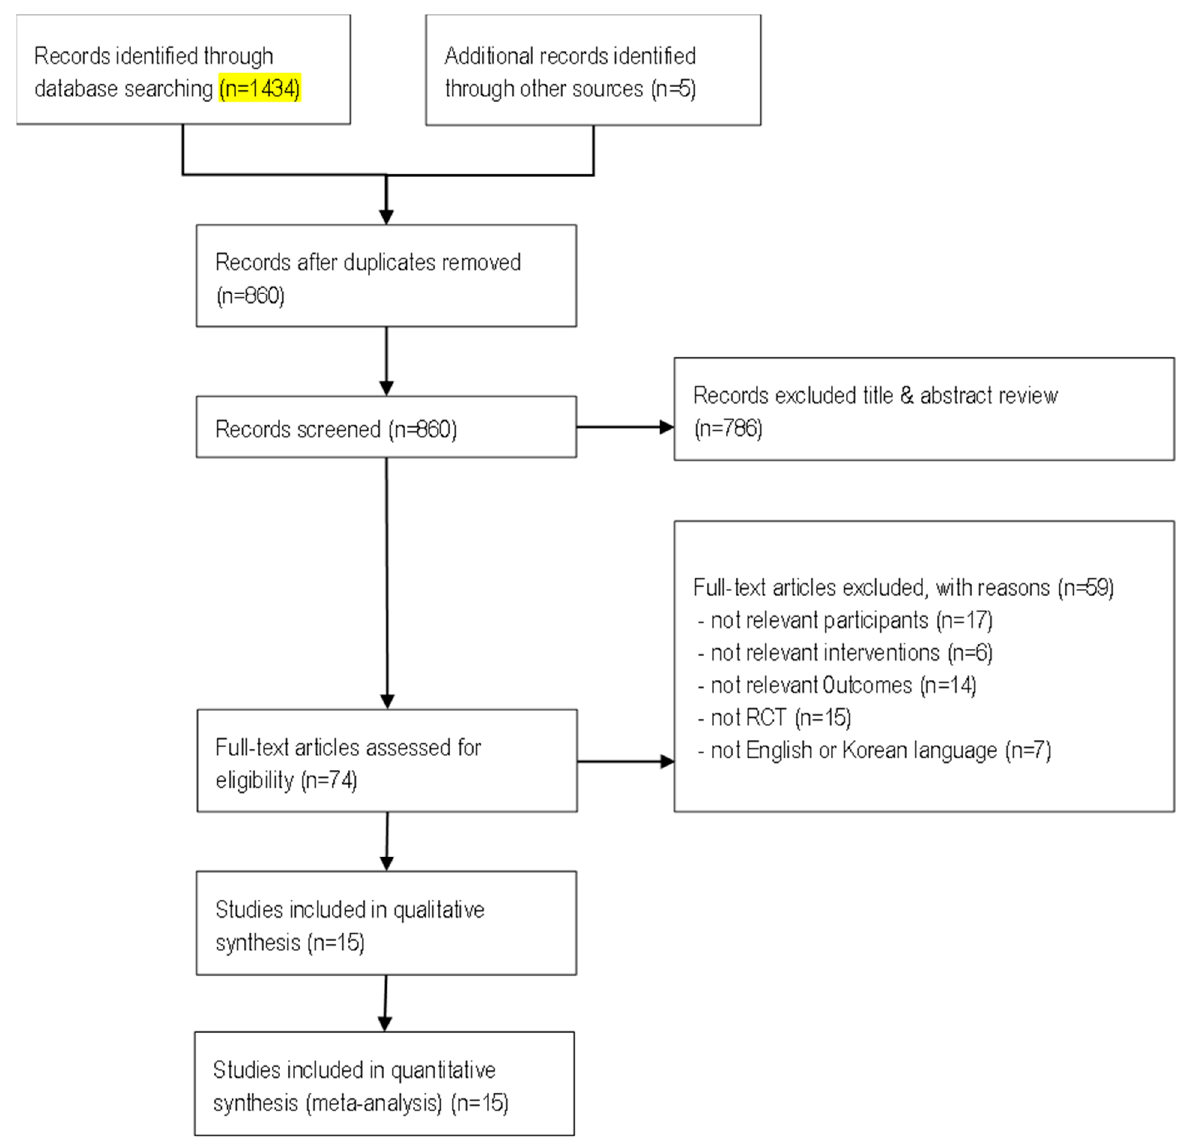
Figure 1. Flow diagram of study selection.